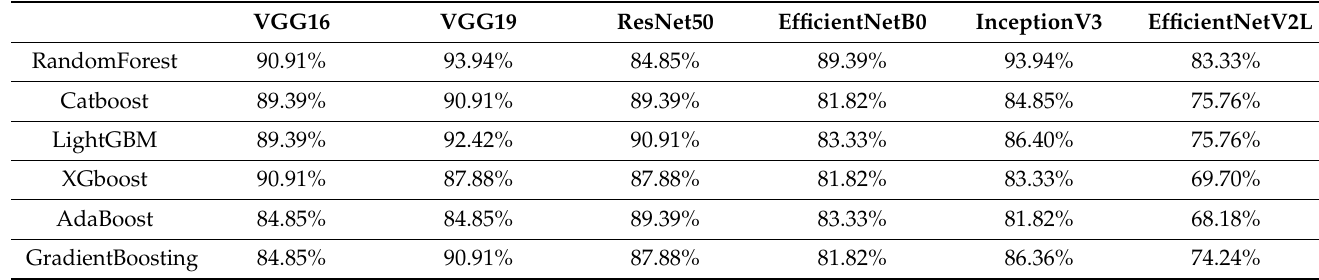
Table A9. Accuracy of each model combination for green circles.